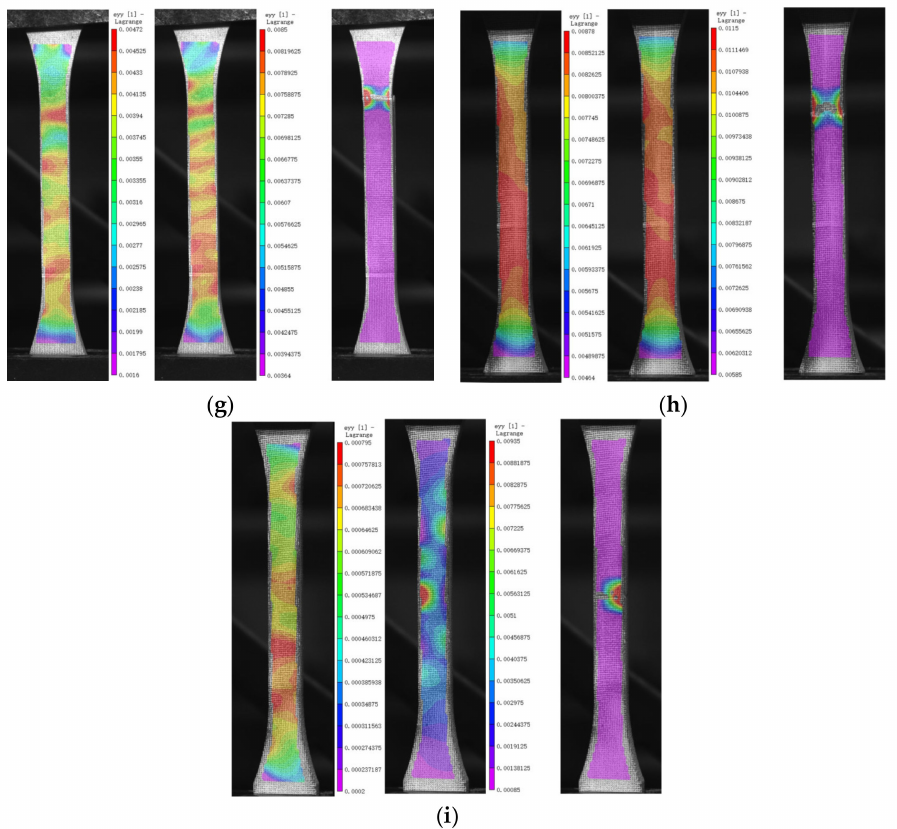
Figure 11. Tensile strain distribution exposed to SW, 5% NaOH, and 5% HCl for 56 d at 20 ◦ C, 50 ◦ C, and 80 ◦ C, respectively. ( a ) SW-20-56, ( b ) 05HA-20-56, ( c ) 05SH-20-56, ( d ) SW-50-56, ( e ) 05HA-50-56, ( f ) 05SH-50-56, ( g ) SW-80-56, ( h ) 05HA-80-56, ( i )